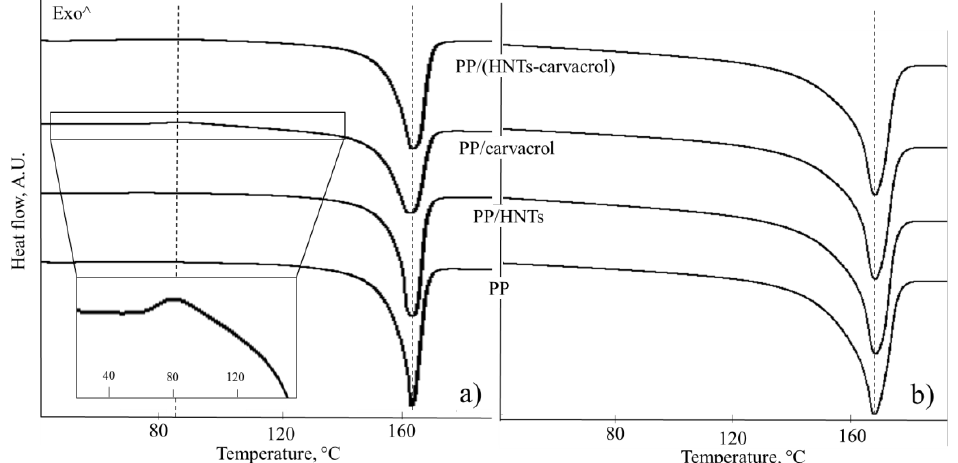
Figure 4. Differential scanning calorimetry (DSC) curves of the PP, PP/HNTs, PP/carvacrol and PP/(HNTs-carvacrol) films: ( a ) first heating and ( b ) second heating steps (at a rate of 10 °C·min −1 ). PP/carvacrol films exhibit solid–solid transition slightly above 80 °C (emphasized in the inset) and appear to have less ordered crystalline structure than the other films. The curves are offset along the Y -axis for clarity. Table 4. Melting, crystallization and glass transition temperatures obtained using DSC; and the degree of crystallinity evaluated, using DSC, FTIR and wide angle X-ray scattering (WAXS) for different films (the number in parenthesis indicate standard deviations obtained from at least three repetitions). DSC FTIR Polymer Film